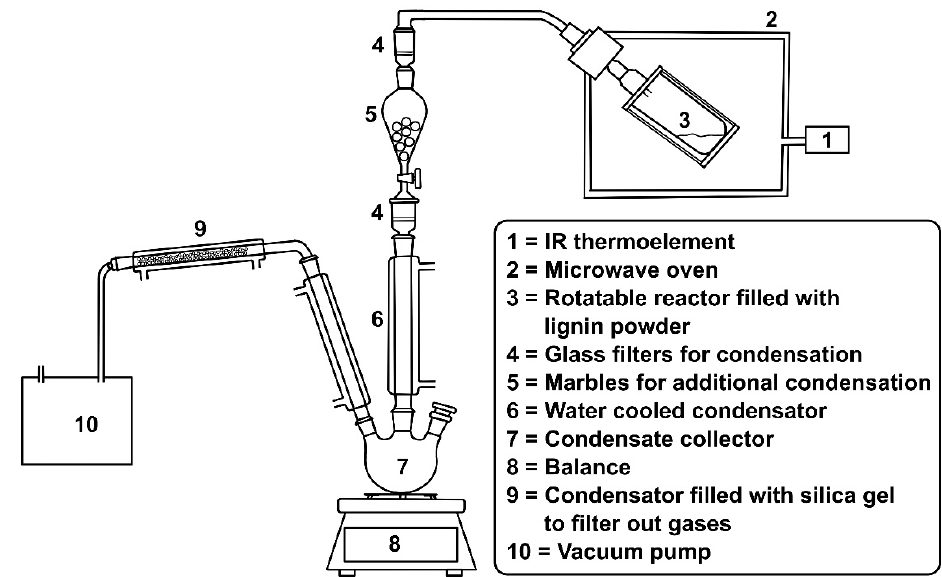
Figure 1. Schematic representation of the pyrolysis